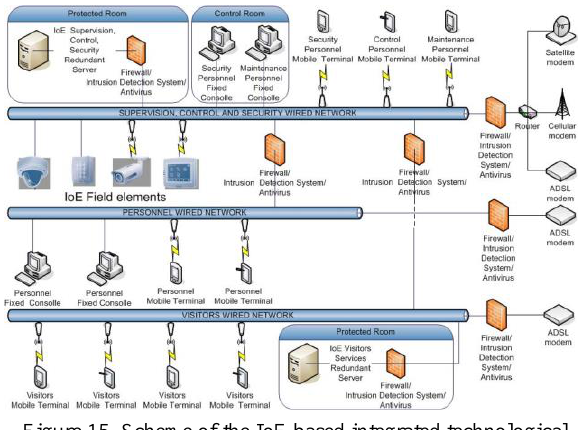
Figure 15. Scheme of the IoE based integrated technological system framework (IoE-ITSF) to support the integrated multidisciplinary model for security and safety management (IMMSSM)